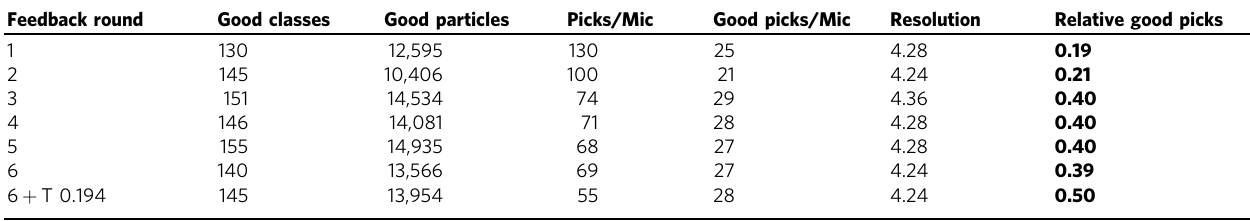
Table 4 Summary of the feedback loop statistics for the Tc holotoxin